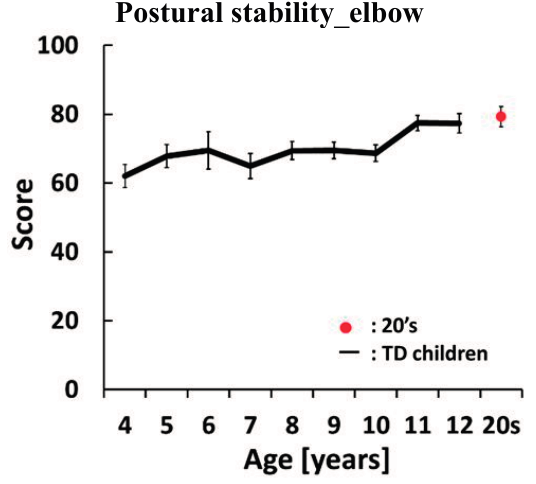
Figure 4. Average and standard error of scores in the maximal-effort motor task performed with both hands. The black line shows the average score for TD children. The red dot shows the average score for participants aged 21–26 years old. There is a significant difference between two different letters which do not include same alphabet on each standard error bars ( p <